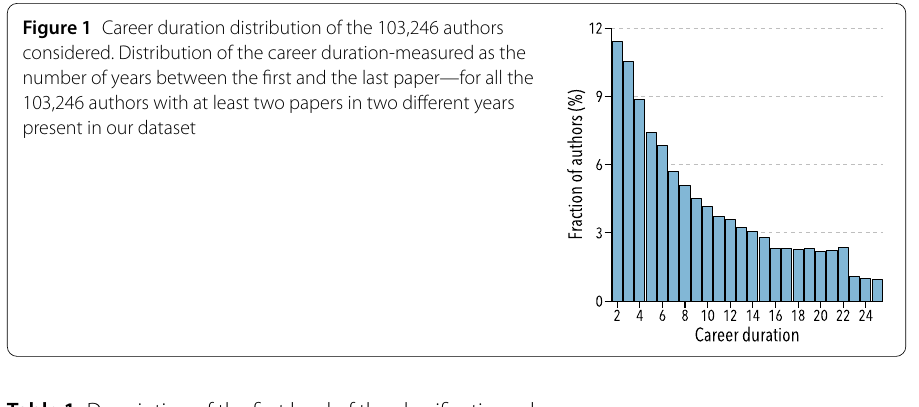
Table 1 Description of the first level of the classification scheme Id